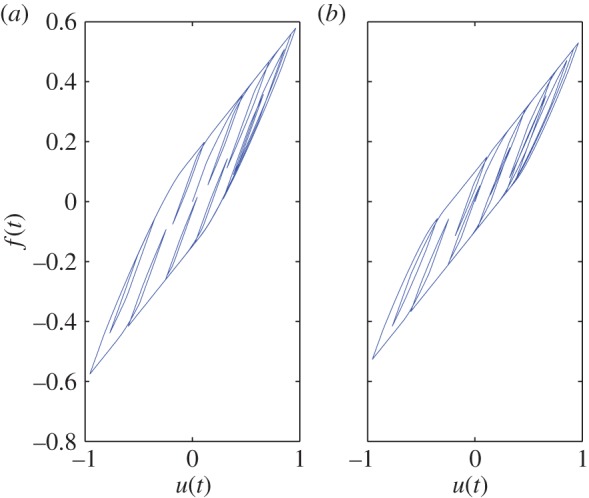
Hysteresis curves for u(t) as in equation (2.5). (a) α=0.0008 and (b) α=0.0012.